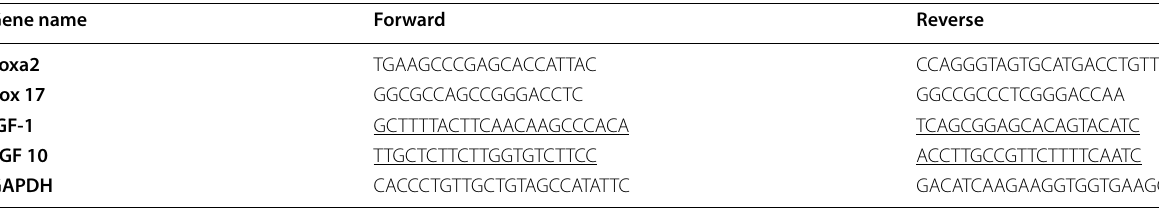
Table 2 List of gene‑specific primers in